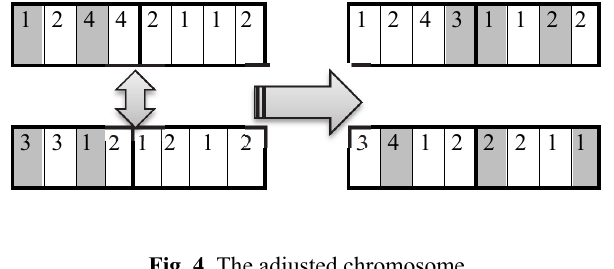
Fig. 4. The adjusted chromosome